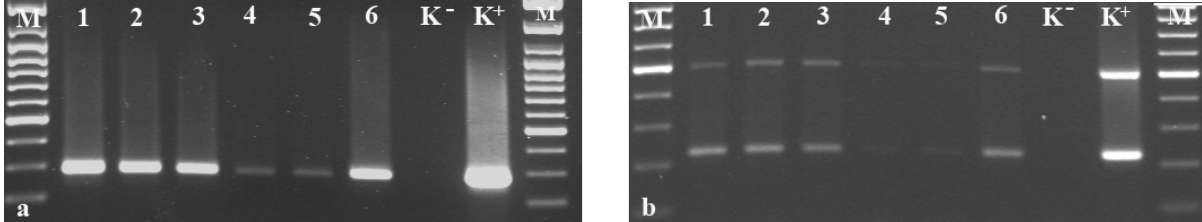
Figure 3. Gel electrophoresis analysis of polymerase chain reaction products amplified by RG-PCR (a) and by duplex- PCR (b) obtained from several twig samples treated as described in the text and collected in orchard W. K - : negative control (water); lanes 1 to 6: twig samples; K - : negative control (water); K + : bacterial suspension (10 8 cfu mL -1 ) of Pseudomonas syringae pv. actinidiae CRA-PAV 1530; M: molecular marker (100 bp DNA Ladder Plus; Fermentas, Lithuania).